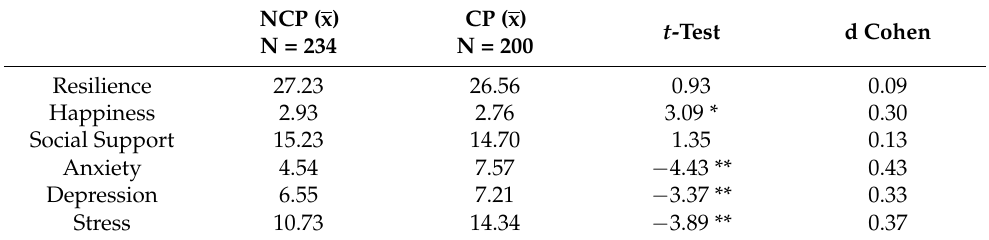
Table 2. Mean comparisons between participants with and without chronic pain.